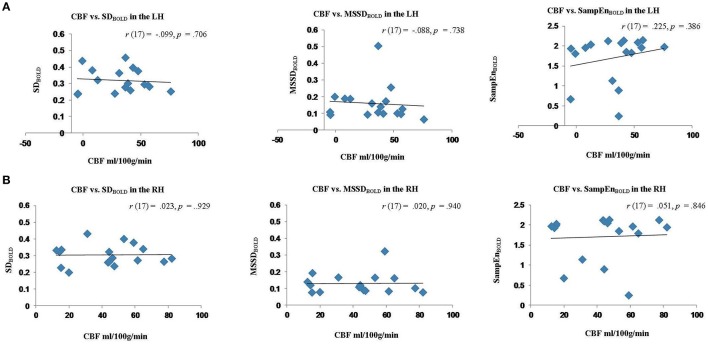
Scatter plots showing the relationship between cerebral blood flow (CBF) measures of BOLD signal variability and complexity (SDBOLD, MSSDBOLD, SampEnBOLD) extracted from the perilesional rim and contralateral RH ROIs for stroke patients. (A) Relationship between CBF and SDBOLD,MSSDBOLD,SampEnBOLD in the perilesional rim. (B) Relationship between CBF and SDBOLD, MSSDBOLD, SampEnBOLD in the contralesional ROI.